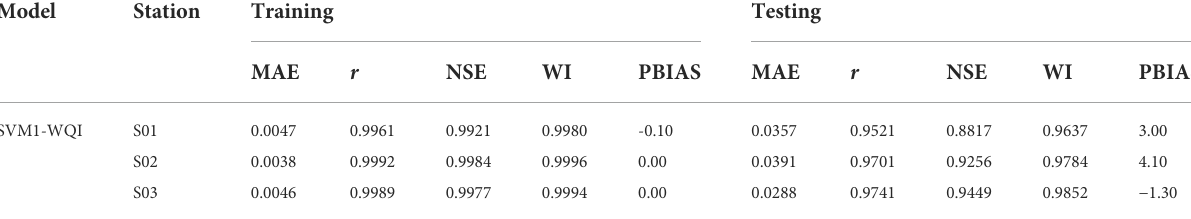
TABLE 7 Performance evaluations for the fi rst scenario. Model